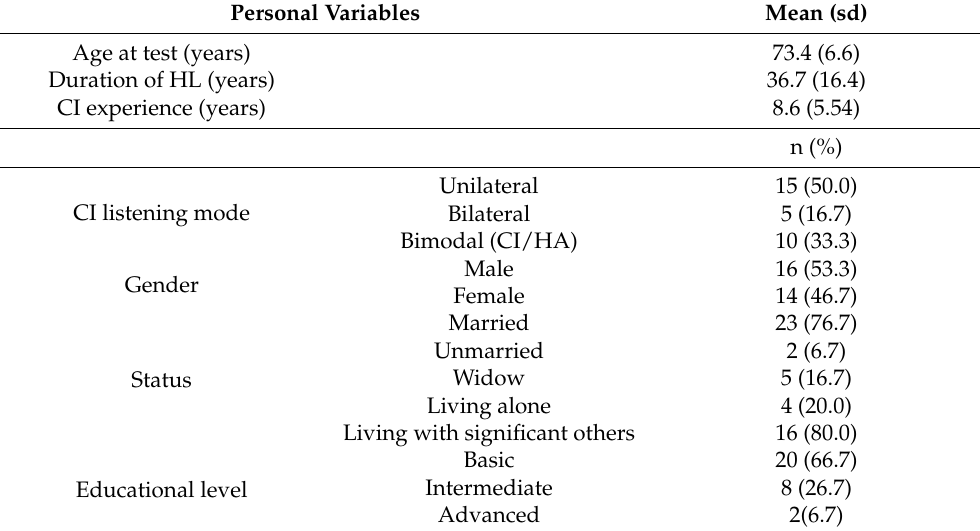
Table 2. Descriptive data of the participants (n =